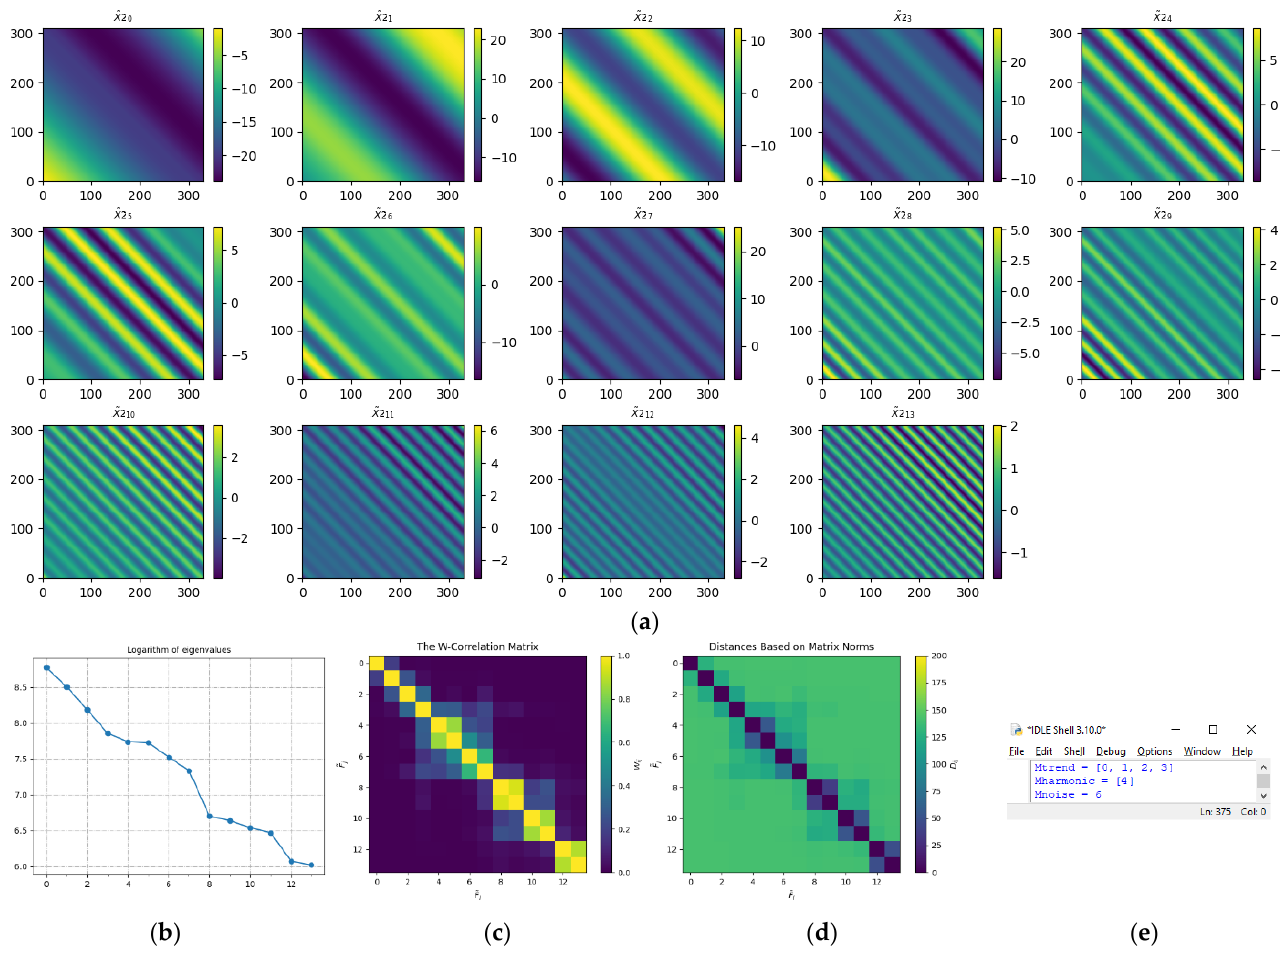
Figure A1. The result of matrix X2 decomposition and principal components analysis: ( a ) Hankelized principal components matrices; ( b ) the first 14 singular values of the trajectory matrix X2; ( c ) w-correlation matrix of distances between pairs of principal components; ( d ) matrix of distances between pairs of principal components based on the Frobenius norm; and ( e ) the result of the proposed algorithm, where Mtrend is the list of indexes of the singular numbers corresponding to the trend, Mharmonic is the set of indexes of the first elements from the pair, and Mnoise is the index of the singular number from which the noise components begin.